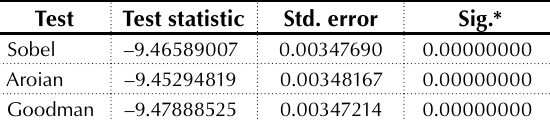
Table 5. Calculation for mediation tests Test Test